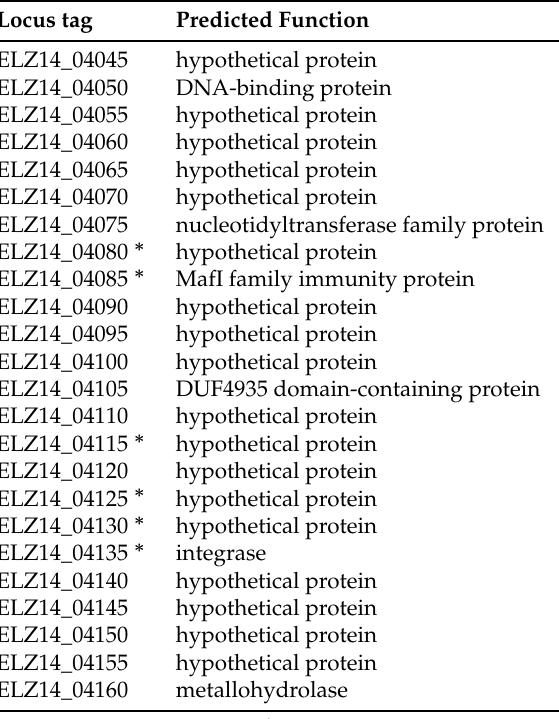
Table 2. Annotation of P. brassicacearum 3Re2-7 singleton cluster_1. Locus tag Predicted